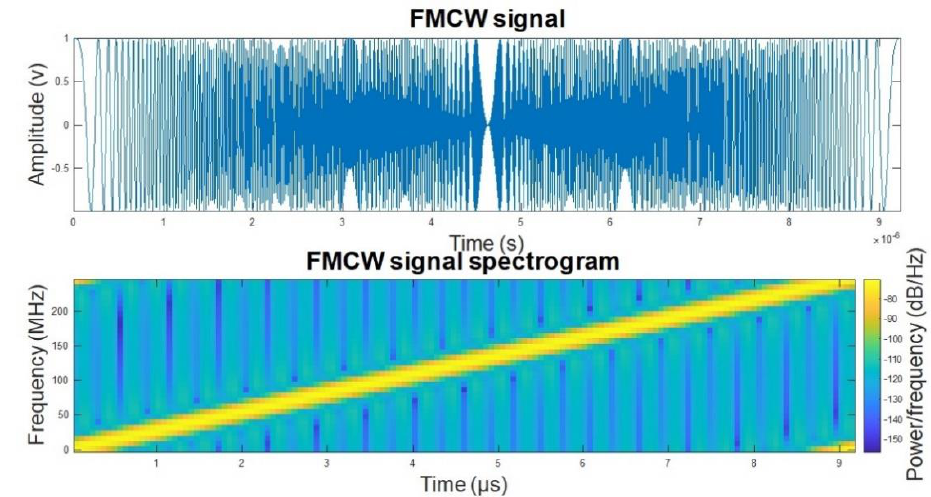
Figure 8. The LRR transmit signal waveform. The automobile in front of the radar is detected by the LRR RDM and 2D-CFAR are shown in Figure 9a,b, respectively. The range and velocity (which have a relative speed of 10 km/h) are measured correctly.